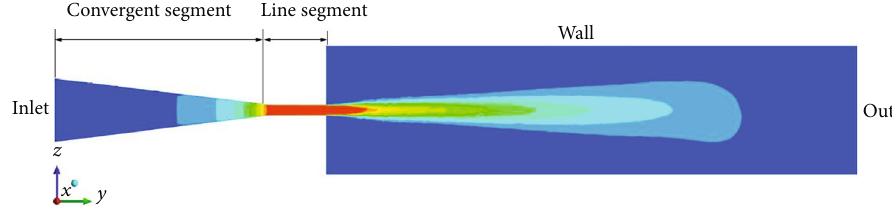
Figure 4: The con fi guration of the numerical model.